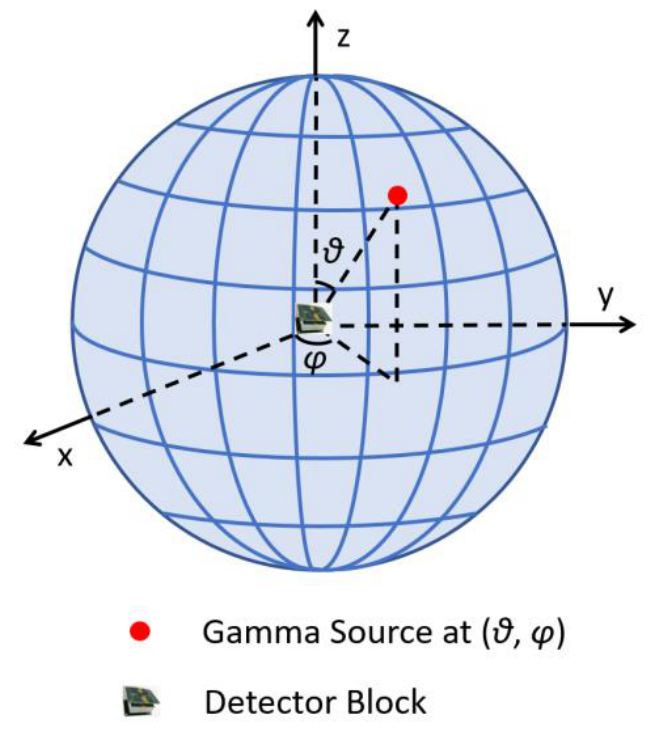
Figure 4. Definition of the spherical coordinate system in the 4π FOV.